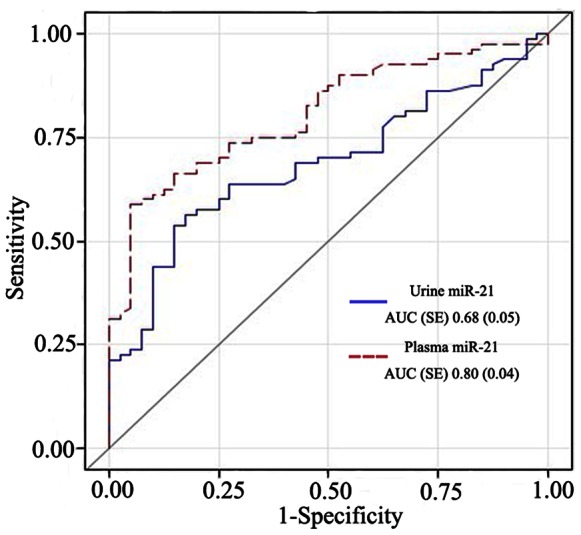
Performance of urine miR-21 and plasma miR-21 for established AKI detection.Receiver-operating characteristic (ROC) curves show the distinguishing performance of urine and plasma miR-21 levels that obtained from 40 patients in the non AKI group and 80 patients in the AKI group.